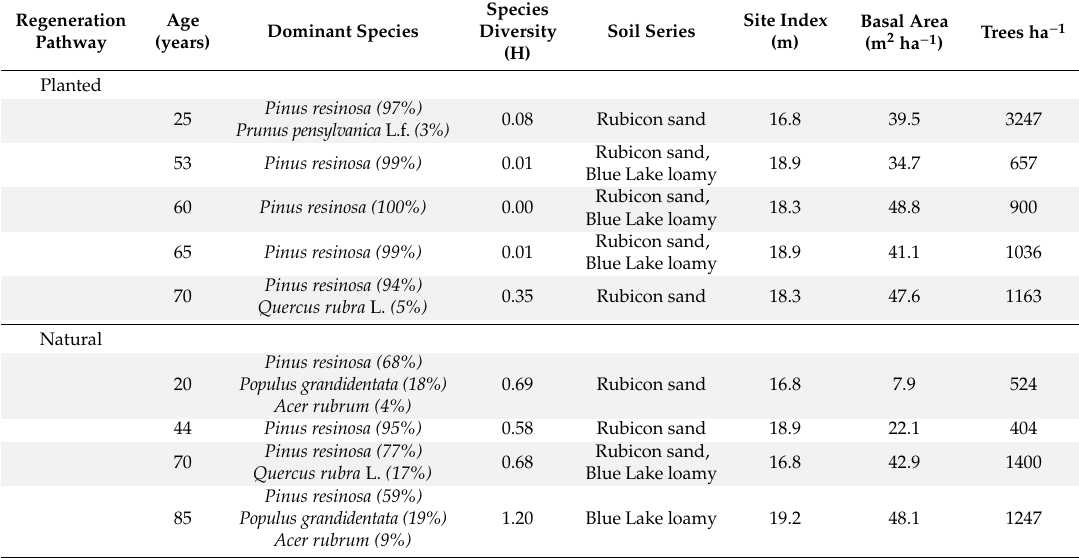
Table 1. Summary of stand characteristics by chronosequence. Species diversity was calculated as Shannon’s Index of Diversity (H) and dominant species ranked according to percent basal area using canopy stem census data from 2017 and 2018. All stems with a diameter at breast height > 5 cm were